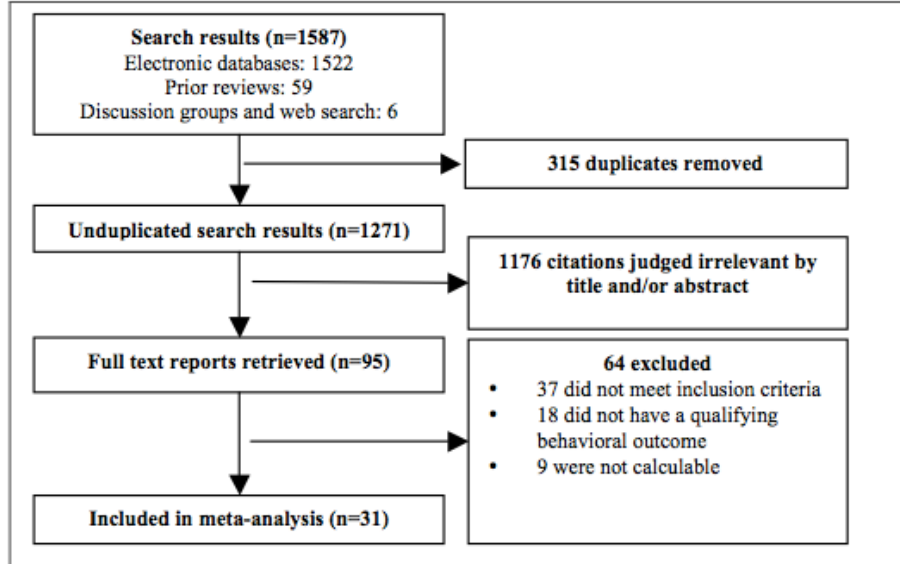
Figure 1. Selection process flow